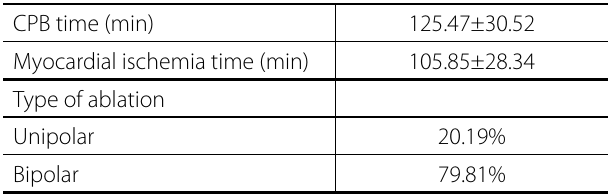
Table 1. Characteristics of the patients studied. Table 2 . Perioperative data.